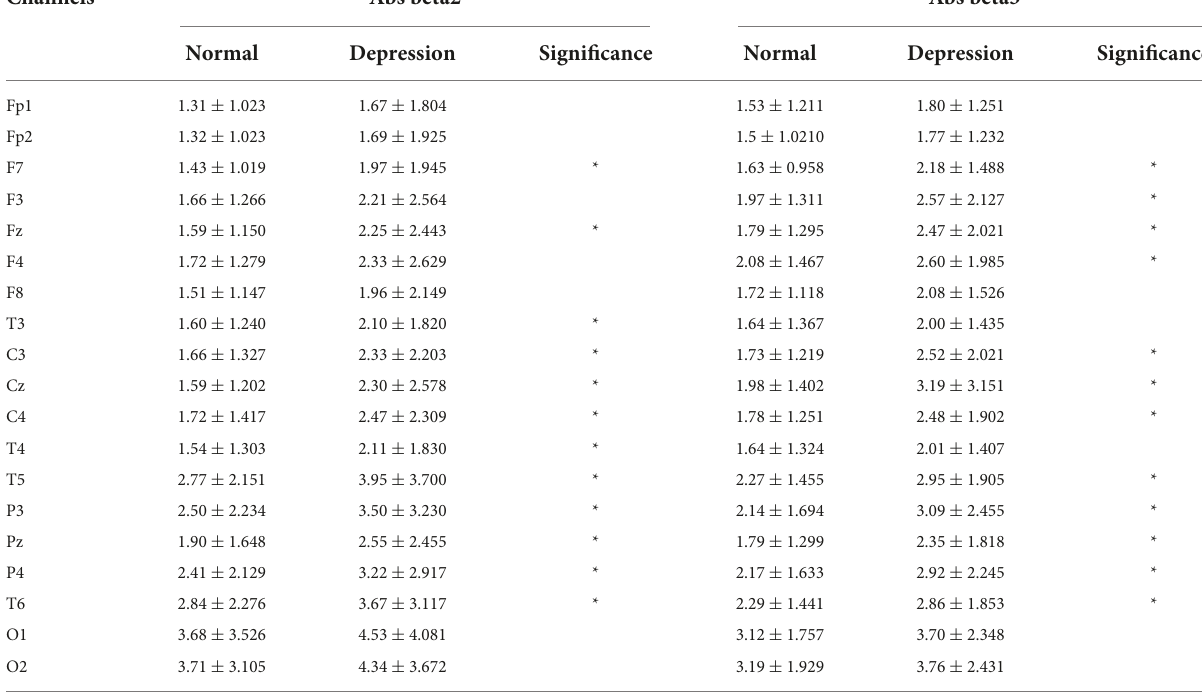
TABLE 1 Numerical values for each channel for absolute beta2 and beta3 power. Channels